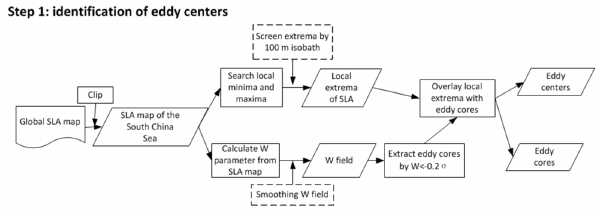
Figure 1. Detailed procedures of step 1. Procedure in the box with dashed border is adaptable according to the data quality and the eddy characteristics of different study regions.